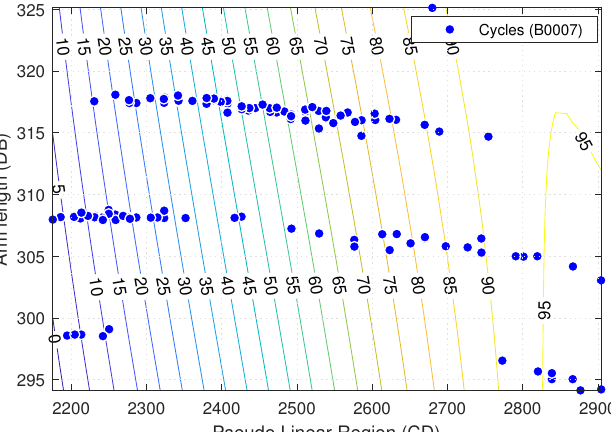
Figure 8. Contour plot showing the effect of cycle number on Arm Length and Pseudo Linear Region at 297.15 K.